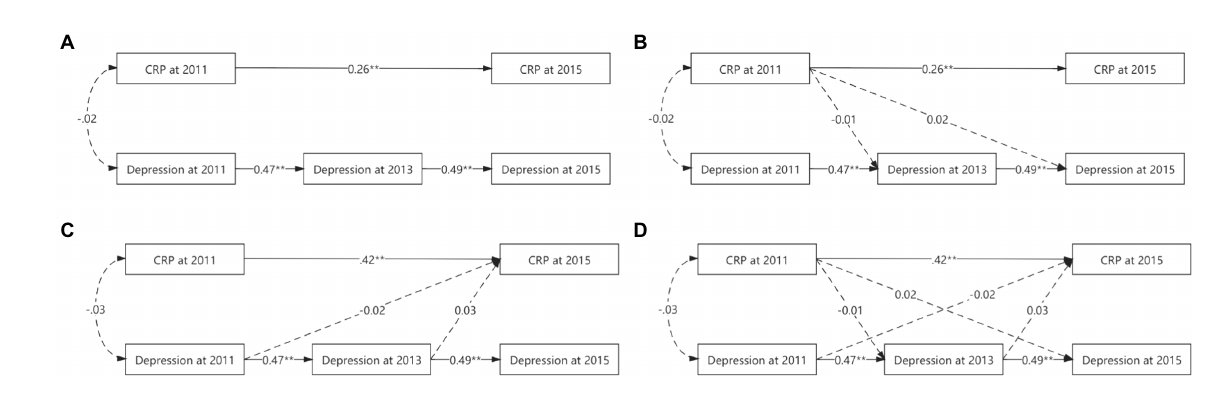
FIGURE 1 Various cross-lagged models’ figures. (A) for autoregressive model. (B) For CRP main-effect model. (C) For depression main-effect model. (D) For reciprocal model. To simplify the figure, the effects of the control variables used and the errors were omitted. While solid lines indicated significant correlation, dashed lines were not. * p < 0.05. ** p <